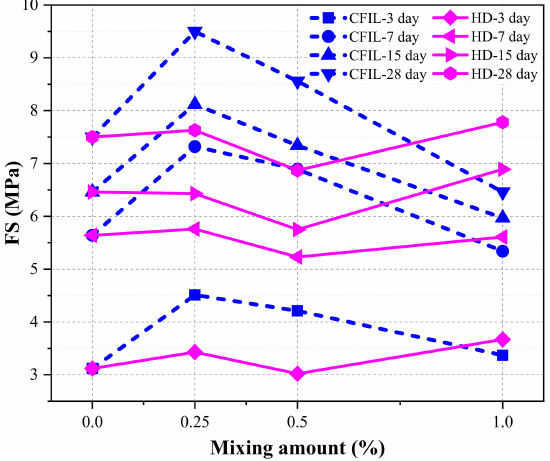
Figure 14. Relationship between FS and mixing